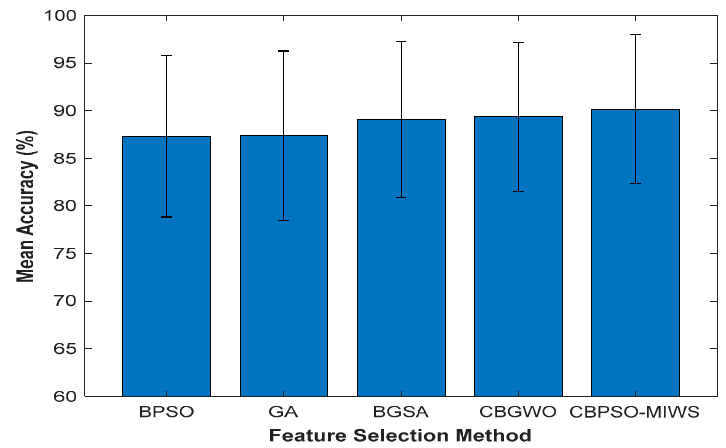
Figure 6. Mean accuracy of five different feature selection methods over 10 datasets.